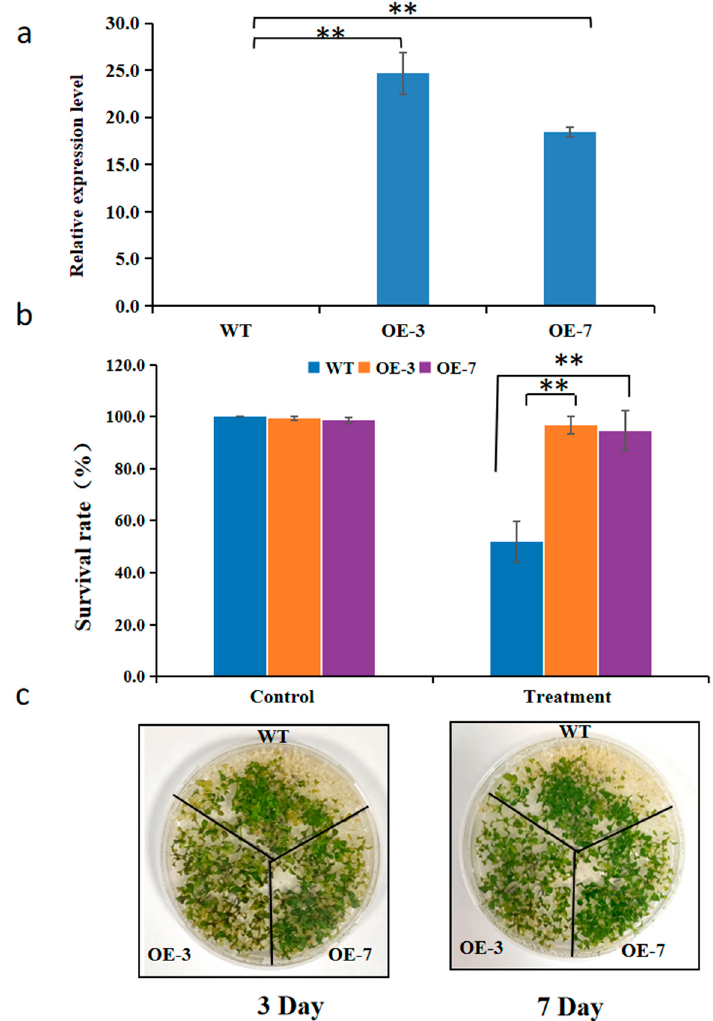
Figure 9. The function of the BnaGLYI11 gene in response to cold stress. ( a ) The expression level of BnaGLYI11 in overexpression A. thaliana lines OE-3 and OE-7 in 7-day-old seedling. ( b ) Survival rate after − 10 ◦ C for cold stress treatment. Two-week-old seedlings grown on MS medium (22 ◦ C with 8 h of light daily) were treated at − 10 ◦ C for 210 min after 4 ◦ C for three days. After cold treatment, the seedlings were incubated at 4 ◦ C in the dark for 12 h and then transferred to normal grown conditions. The survival rates of the seedlings were scored visually after 7 days. WT: wild-type (Col-0), OE: BnaGLYI11 gene overexpression lines. ( c ) phenotype of wild-type (Col-0) and transgenic BnaGLYI11 gene after − 10 ◦ C treatment. Asterisks represent the statistical significance between the means for each treatment. ** p < 0.001. Vertical bars in the graph represent mean ± SD.